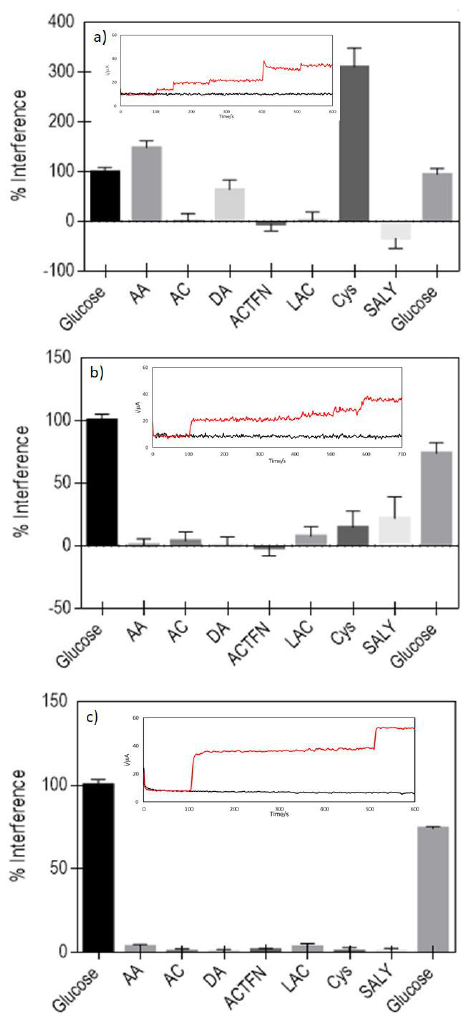
Figure 11. Sensibility of enzymatic electrodes to interferents. The interference percentage of the current obtained for the TMPyP/GSH-CdTeQD/GOx electrodes without ( a ) and with BSA incubation for 30 ( b ) and 90 ( c ) minutes. Inserts show the corresponding chronoamperograms.